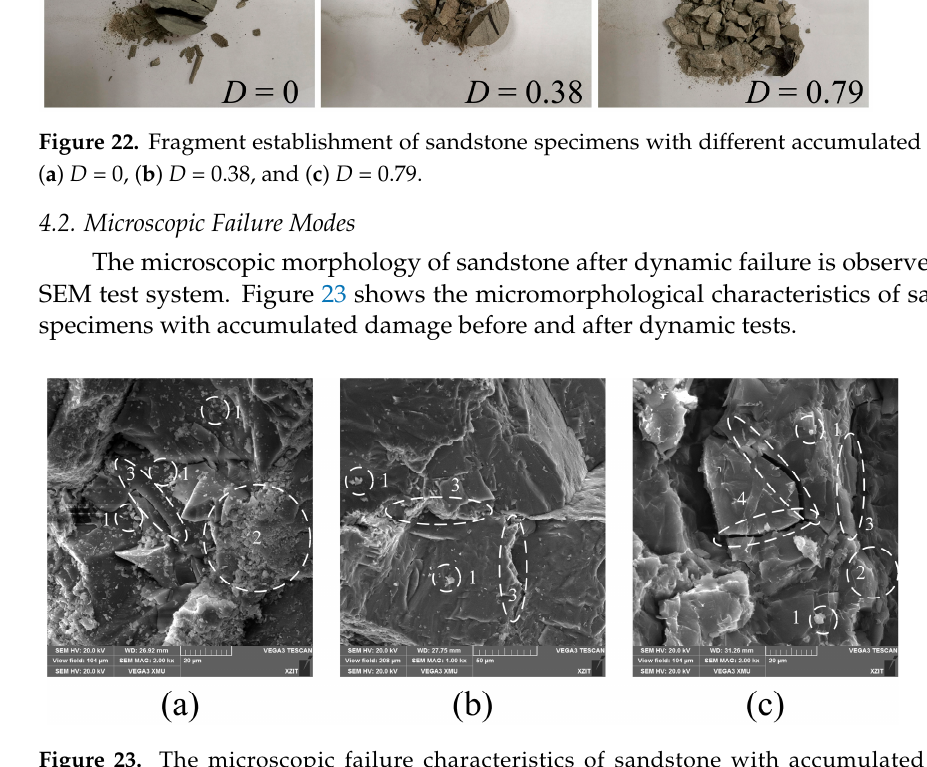
Figure 23. The microscopic failure characteristics of sandstone with accumulated damage: ( a ) sandstone specimen not subjected to impact load; ( b ) sandstone specimen at a low impact velocity; ( c ) sandstone specimen at a high impact velocity (1: tiny mineral particles; 2: rough surface; 3: intergranular fracture; 4: transgranular fracture).